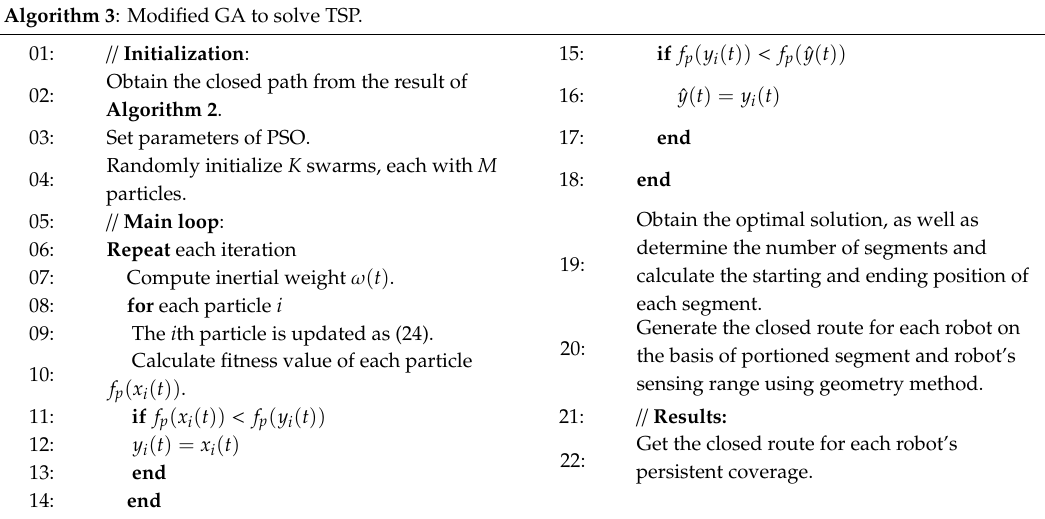
Algorithm 3. Pseudo-code of particle swarm optimization (PSO) for path partition. Algorithm 3 : Modified GA to solve TSP.